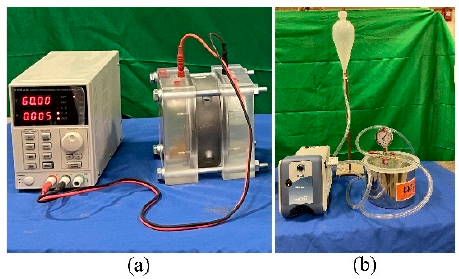
Figure 4. RCPT: ( a ) power supply and test cell and ( b ) vacuum pump and